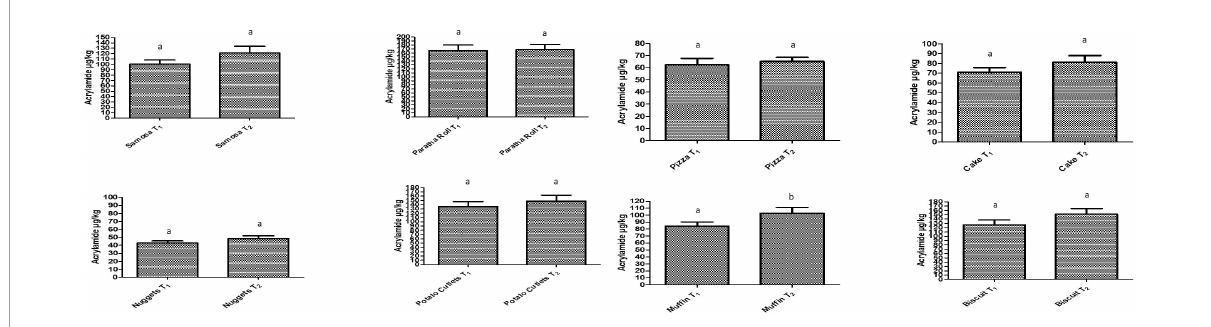
FIGURE1 Acrylamide concentrations ( µ g/kg) in various bakery (Pizza, cake, muffins, and biscuits), snack (Chicken nuggets and potato cutlets), and fried (paratha roll and samosa) products.